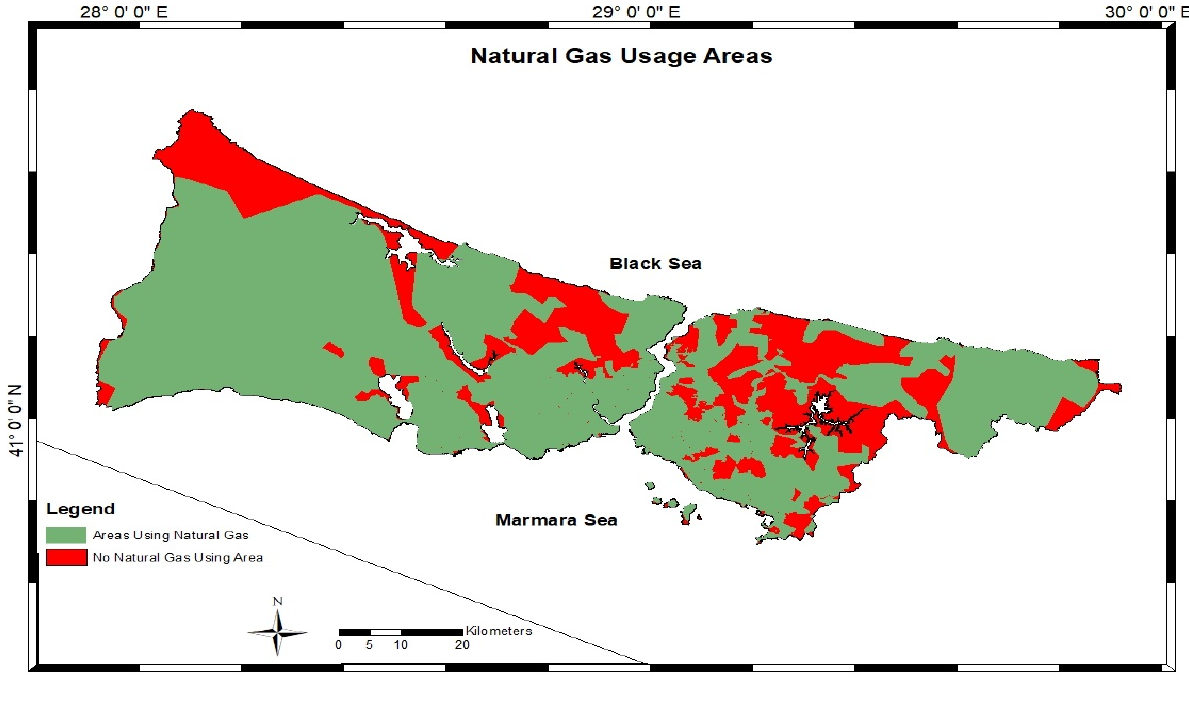
Figure 11. Natural gas usage areas.